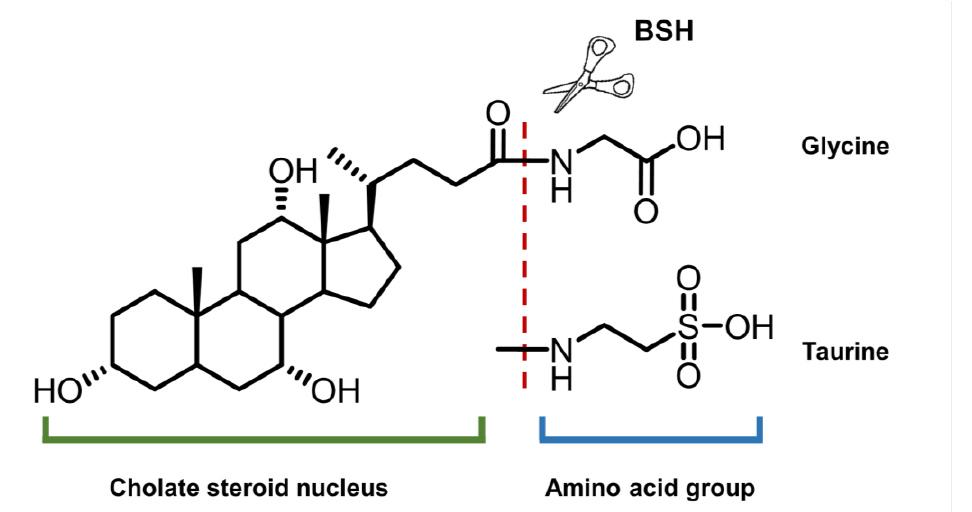
FIGURE 11: General struc- tures of bile salts and the functions of BSHs.